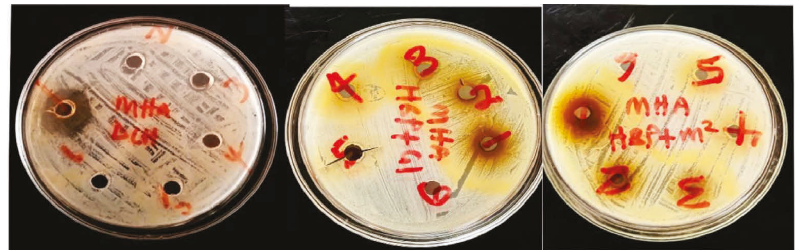
Figure 2: Zone of inhibition of honey on Staphylococcus aureus .